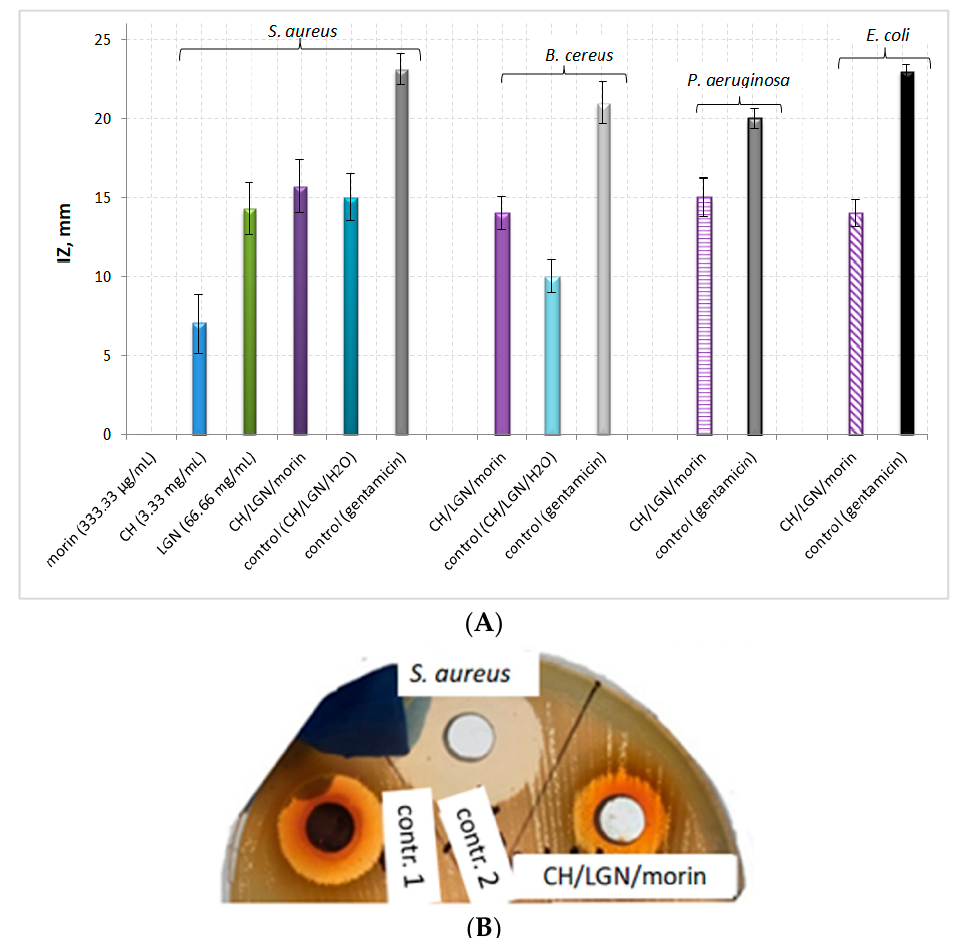
Figure 3. Antimicrobial potential of the three-component morin–chitosan–lignin system against S. aureus , P. aeruginosa , B. cereus and E. coli . (All experimental results were statistically significant: p < 0.005.): ( A ) Graphical representation of the experimental data; ( B ) A photo of the inhibition zones against S. aureus .